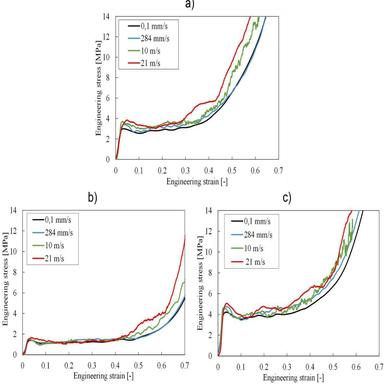
Average stress–strain relationships for a) ACS_V1, b) ACS_V2_RD6 and c) ACS_V2_RD9 at different loading velocities.